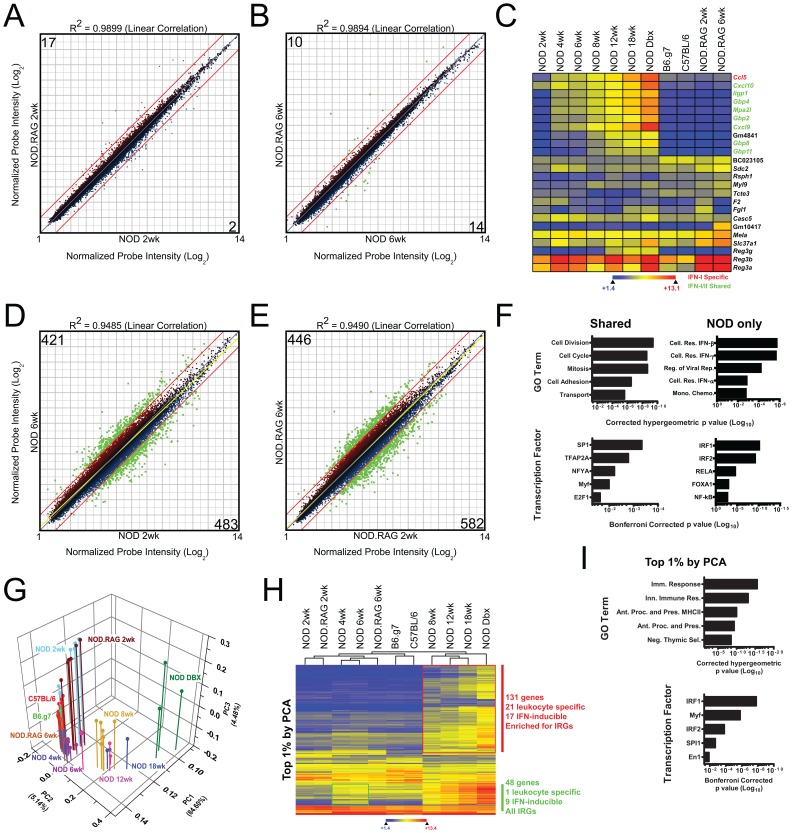
Pairwise and principal component analysis of microarray data.(A–B) Scatter-plots of the normalized probe intensity of all annotated microarray signals are shown. Each dot represents the mean of 6 independent biological replicates. Numbers in the box represent the number of features that were at least 2-fold different at a 99% confidence interval by moderated t test with Benjamini-Hochberg false discovery rate analysis. Data are plotted at a log2 scale. Panel (A) compares NOD.Rag−/− mice versus NOD mice at 2 wks of age and panel (B) compares them at 6 wks of age. (C) Hierarchically clustered heat map (Euclidean row distance) of the 24 differentially expressed transcripts identified in (B). (D–E) Scatter-plots as in (A–B) except the comparison is between 2 and 6 wk old NOD or 2 and 6 wk NOD.Rag−/−. (F) GO terms and transcription factor binding analysis of the differences identified in (D–E). The two graphs on the left, labeled ‘Shared’ show signatures common to both NOD and NOD.Rag−/−. The signatures on the right, labeled ‘NOD only’, show changes specific to the NOD strain. (G) Principal component analysis of microarray samples. Each of 57 microarrays is summarized as a point and drop-line. Samples are color coded as indicated by the title of each group. (H) Hierarchical clustered heat map (Euclidean distance) of the top 1% most variant genes identified by principal component. (i) GO and transcription binding analysis of the top 1% most variant genes identified by principal component analysis.